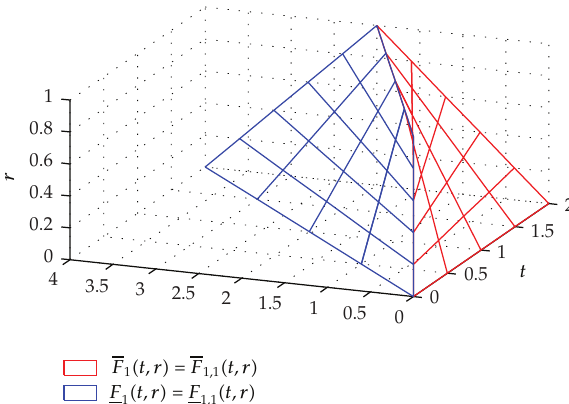
(cid:6) t,r (cid:7) for Example 4.1. 1 , 1